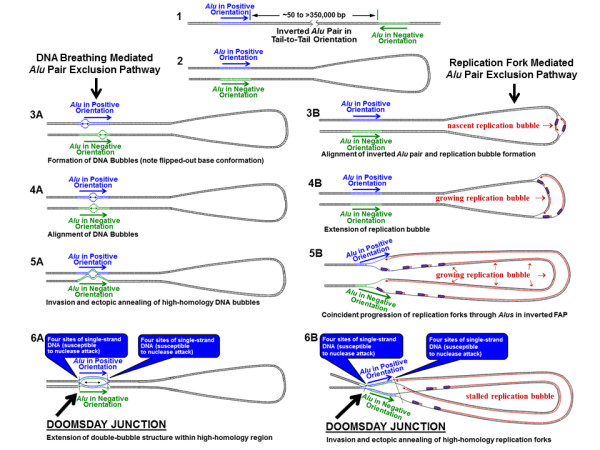
Possible mechanisms for formation of G and S phase DDJ. Steps 1 and 2 illustrate an inverted FAP. When the DNA in Step 1 is bent 180°, the two Alu elements within the inverted FAP are aligned. Steps 3A-6A and 3B-6B illustrate two possible mechanisms for interactions between inverted Alu elements without the formation of a hairpin loop. Steps 3A-6A, DNA Breathing (G phase) Mediated APE deletion. (3A) DNA breathing bubbles are typically < 20 bp [45] and are characterized by flipping of the unpaired nucleotide bases away from the center line of the double-helix [37]. A bubble in this conformation could be susceptible to interaction with a bubble of similar sequence. (4A) Simultaneous bubbles may arise in identical sections of aligned Alu elements. (5A) Simultaneous homologous bubble alignment could initiate bubble-bubble interaction with the potential for forming a 'double-bubble' conformation. (6A) The ectopic formation of the double-bubble conformation within two aligned breathing bubbles could potentially extend to the entire length of the two aligned Alu elements. The high GC content of Alu elements would likely increase the stability of the hypothesized doomsday junction. DDJs likely possess four single-stranded sections of single-stranded DNA at each end which could be susceptible to single-strand nuclease attack. Steps 3B-6B, Replication Fork (S phase) Mediated APE Deletion 3B-5B) Initiation and growth of a replication bubble. (5B) Coincident progression of the DNA replication bubble through an inverted FAP. (6B) Invasion and ectopic annealing of high-homology replication forks. APE: Alu pair exclusion; DDJ: doomsday junction; FAP: full-length Alu pair.